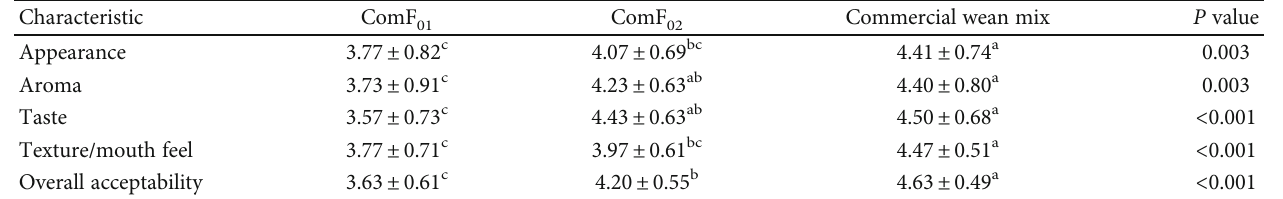
The results are presented as SD of the means. ComF maize+red te ff +insect bee larvae); commercial wean mix (Mama ’ s Choice); means with di ff erent superscripts (alphabets) in the same row are signi fi cantly di ff erent ( P < 0 : 05